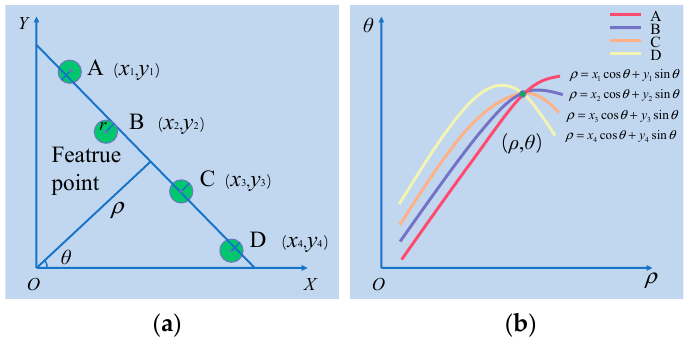
Figure 7. ( a ) Rectangular coordinate system; ( b ) Polar coordinate system.